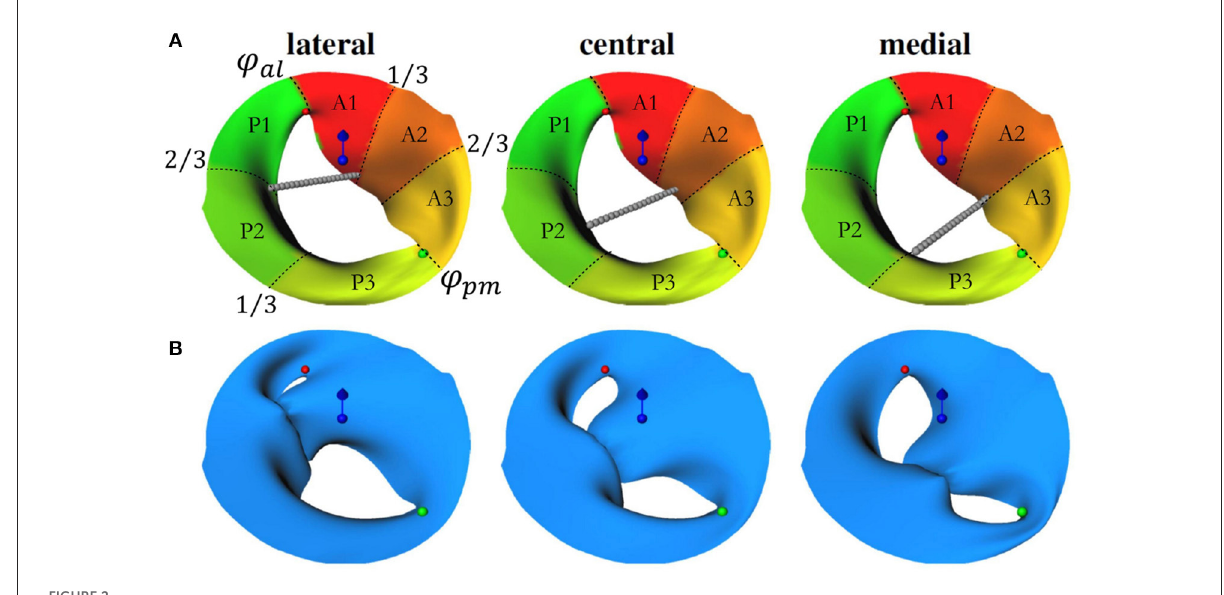
FIGURE2 (A) Visualization of the automated setup for the device positioning. Red and green spheres depict the anterolateral (at ϕ al = 0) and posteriomedial commissures (at ϕ pm ). Sectors in red-yellow mark the anterior leaflet segments ( ϕ ∈ [0, ϕ pm ]), yellow-green sectors mark the posterior leaflet segments ( ϕ ∈ [ ϕ pm ,2 π ]). The center of gravity of the annulus is marked by the blue sphere while the blue vector shows the annulus plane normal. The gray chains of spheres indicate lateral, central, and medial device positions and depict which sectors are to be connected in the simulation. (B) Geometries after virtual TEER and slight postprocessing. Similar to (A) , commissure positions, annulus plane normal, and center of gravity are